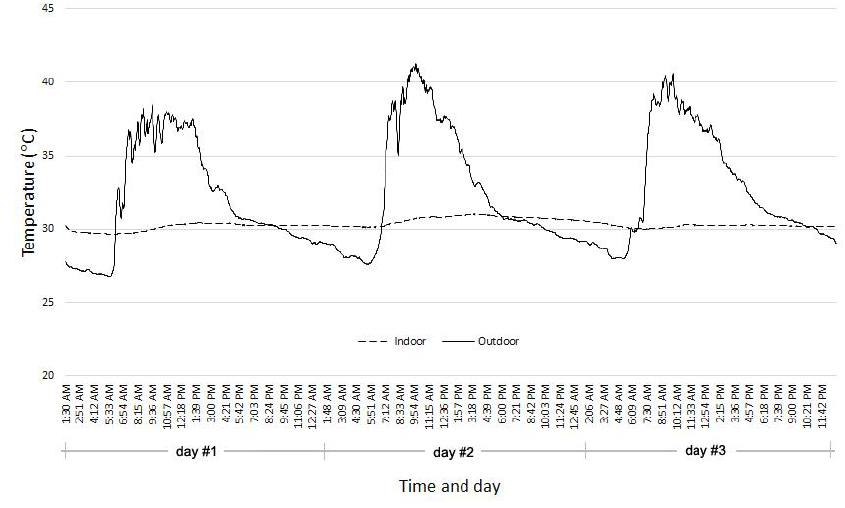
Fig. 13. Outdoors and indoors temperature recorded of B apartment.